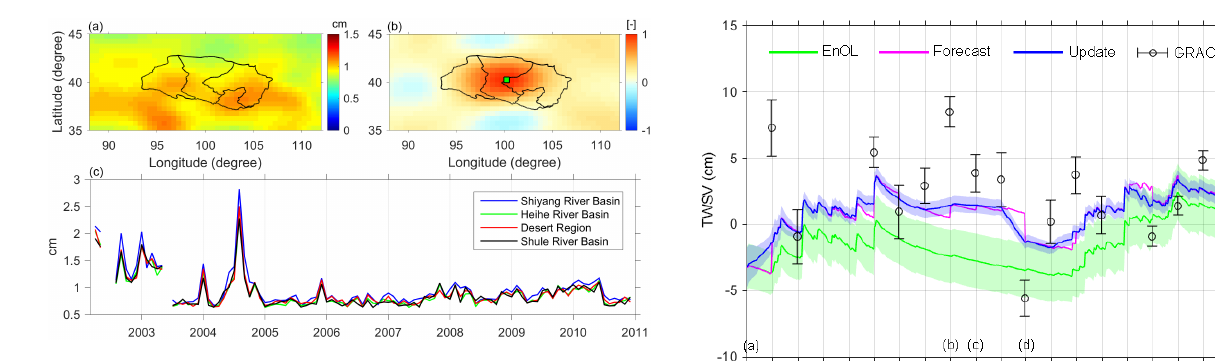
Figure 8. Some statistics of errors in GRACE-derived TWS vari- ation over the Hexi Corridor. The standard deviation (a) and the correlation coefficient with respect to the green point (b) for a sam- ple month, October 2002, are shown at the top. The time series of averaged standard deviation computed over four different basins are shown in the bottom plot (c) .